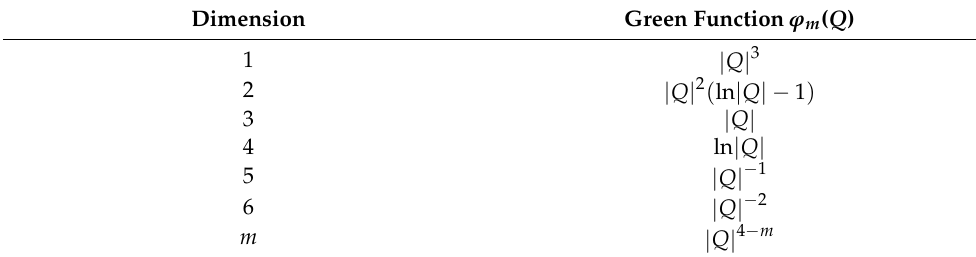
Table 2. m-dimensional Green function.